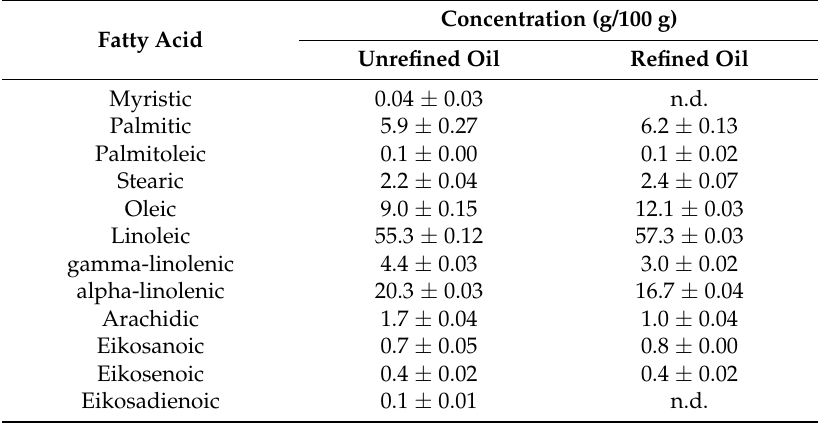
Table 1. Composition of fatty acids (g/100 g) in unrefined and refined hemp seed oils determined by gas chromatography (GC).